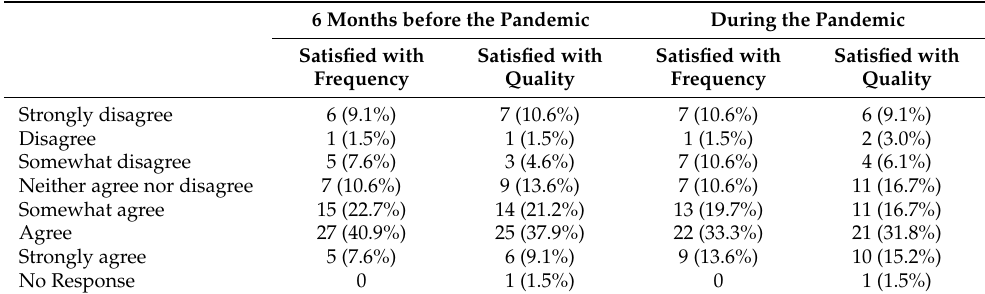
Table 2. Satisfaction on interprofessional care interaction and telehealth usage, n = 66.